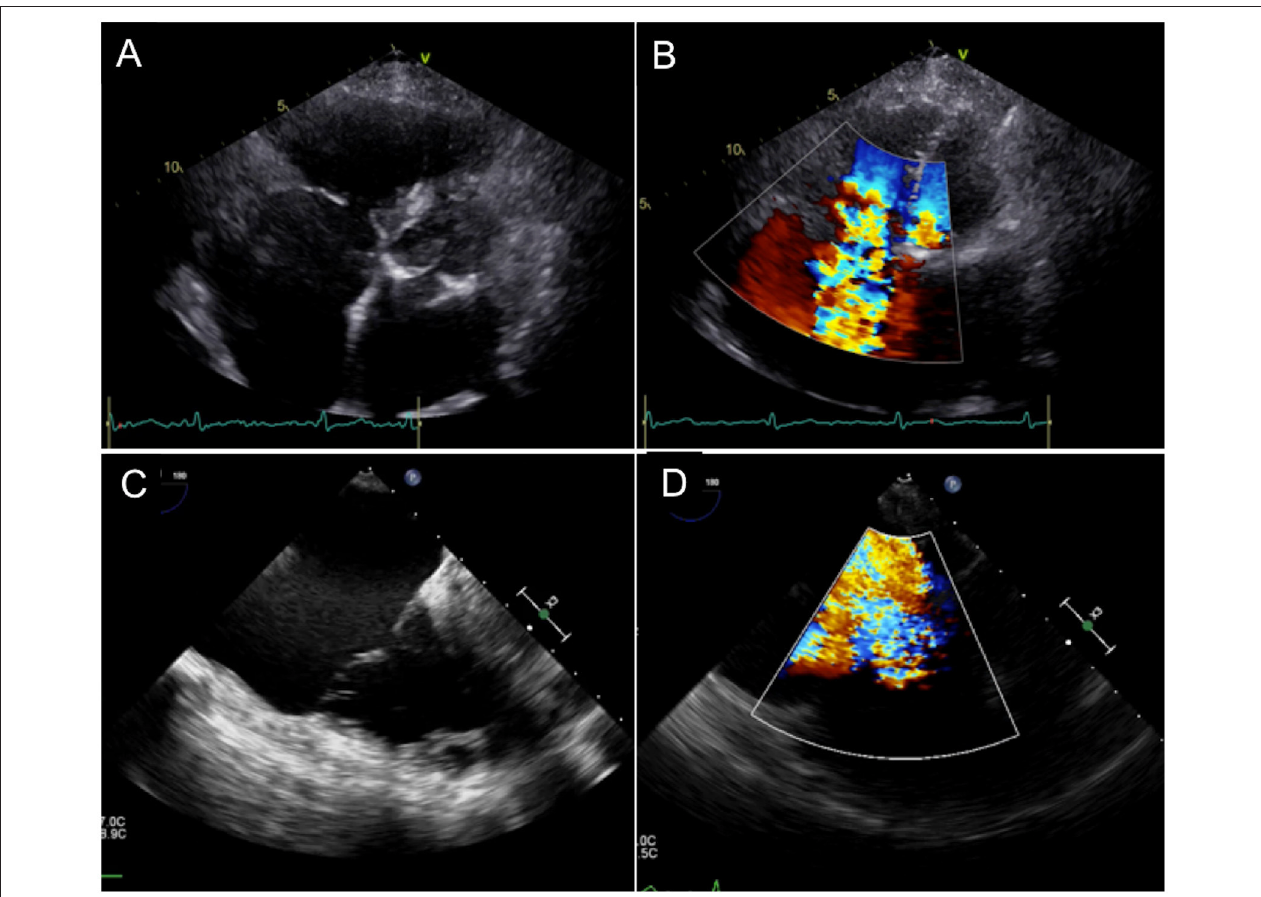
FIGURE 2 | Echocardiographic Evaluation of Severe Tricuspid Regurgitation and its etiology. (A,B) Extreme tethering and annular dilatation with loss of coaptation, resulting in severe valvular regurgitation. (C,D) Large posterior leaflet prolapse with severe eccentric regurgitant